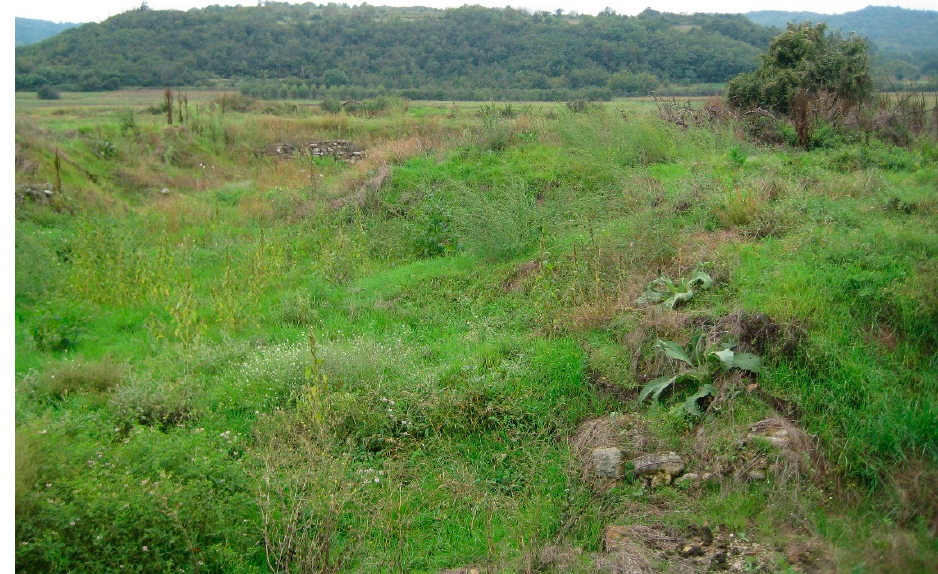
Figure 4. View from inside the military camp (horreum) towards the hill of Slog to the west of Timacum Minus (photo by L. Diers).